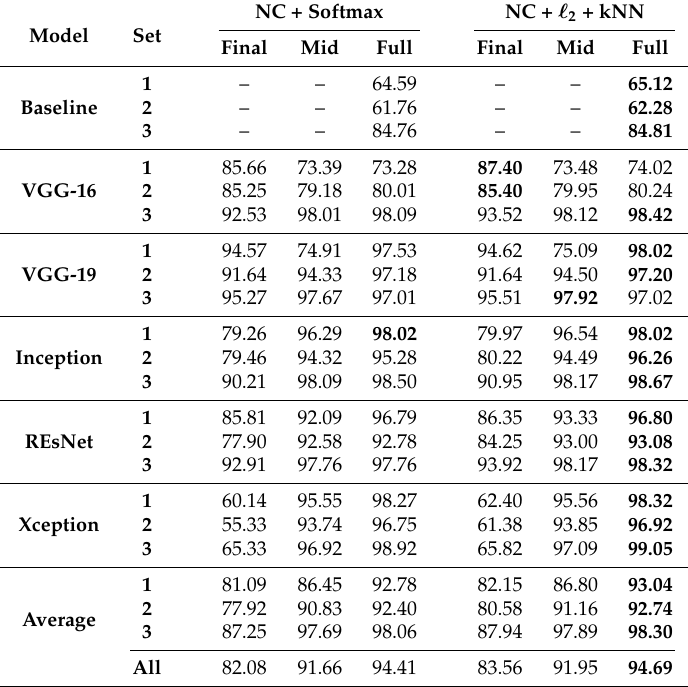
Table 4. F 1 (%) measure obtained for the proposed CNN approaches using the three sets from the MASATI dataset considering the classification of the main class (ship or non-ship). The last rows show the average values excluding the baseline network. The best result for each model and set is shown in bold